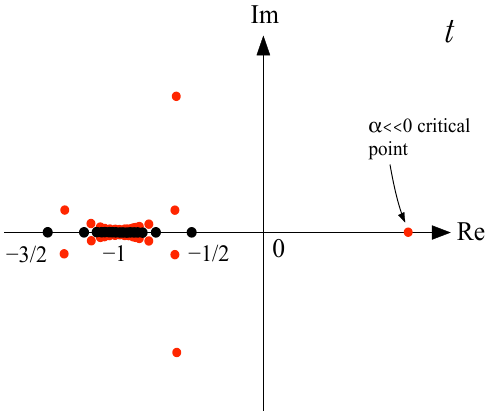
Figure 5 . Location of saddle points and singularities in the integrand of the ghost number zero tachyon in the Schwinger plane. The black dots represent essential singularities related to poles of the cotangent. There are an in(cid:12)nite number of them, and they accumulate towards t = (cid:0) 1. The singularity with closest proximity to the origin is at t = (cid:0) 1 = 2. The red dots represent saddle points. The saddle points which are clustered around the essential singularities correspond to the roots x n ; n (cid:21) 1 of the equation x = sin x . In addition there are three saddle points, shown here for (cid:11) < 0, whose location approaches in(cid:12)nity as j (cid:11) j becomes large. We show these saddle points for (cid:12)nite (cid:11) so that they can be seen on the same scale as the singularities on the negative real axis. The saddle point on the positive real axis dominates the behavior of the solution for (cid:11) (cid:28) 0. This is shown in (cid:12)gure 5. These saddle points, however, are not directly relevant for